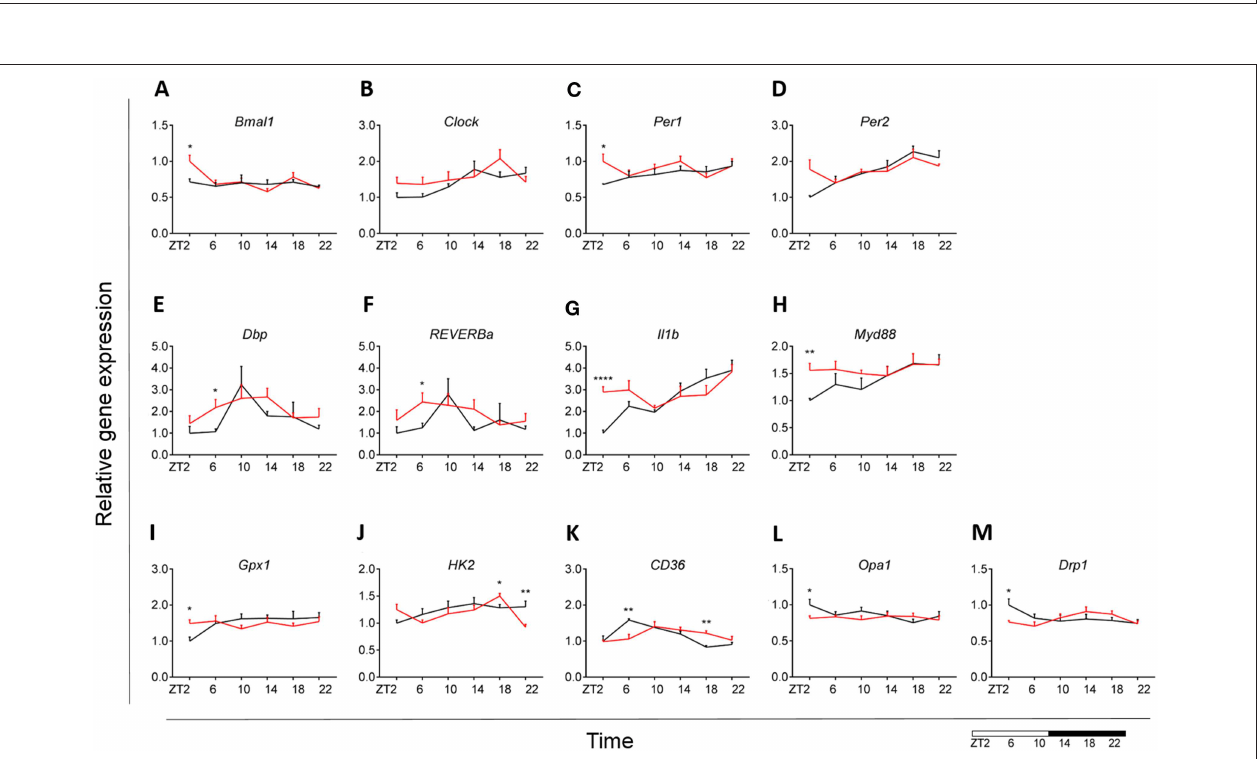
FIGURE 7 | Monocyte immunometabolism in DIO. Relative gene expression of circadian genes Bmal1 (A) , Clock (B) , Per1 (C) , Per2 (D) , Dbp (E) , and Reverba (F) ; immune genes Il1b (G) and Myd88 (H) , antioxidant enzyme gene Gpx1 (I) , glycolysis gene Hk2 (J) , fatty acid sensing gene Cd36 (K) , and mitochondria dynamic genes Opa1 (L) and Drp1 (M) in HFD-fed rats (red) compared to Chow-fed controls (black) evaluated at six time points, starting at ZT2. Data are presented as means ± SEM. Statistical significance was determined using Two-way ANOVA effect for Interaction , Diet, and Time (ZT); Student t -test is used for diet effect within a separate time point (* p < 0.05; ** p < 0.01; **** p < 0.0001). Scale (bottom right) represents light (ZT0-12) and dark (ZT12-24) phase.